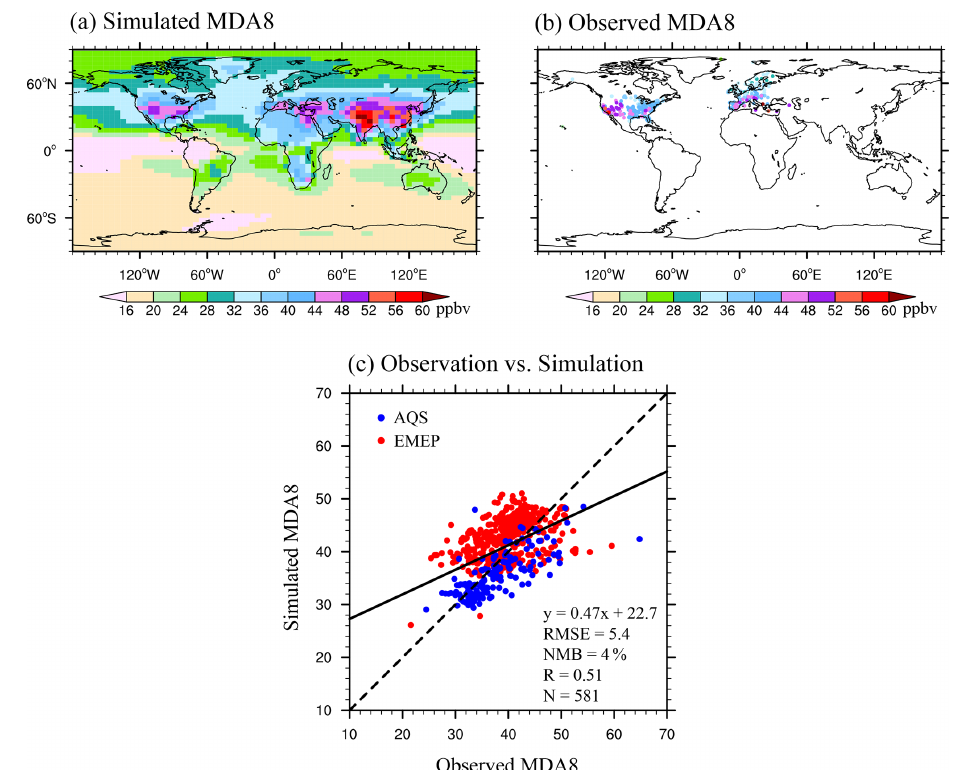
Figure 2. Spatial pattern of (a) simulated and (b) observed surface [O 3 ]. (c) Scatter plot of surface [O 3 ] over measurements in two regions. The black line shows the linear regression between the observed and simulated [O 3 ]. The regression fit, correlation coefficient ( R ), root mean square error (RMSE), and normalized mean bias (NMB) are shown in the bottom panel with an indication of site numbers ( N ) used for statistics.